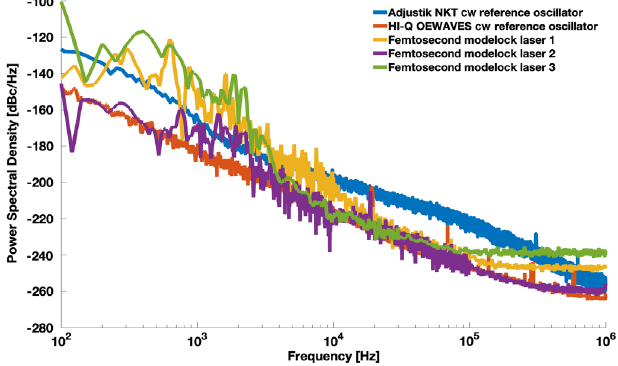
FIG. 3. Top: power spectral density of phase noise measured from self heterodyne beating for two cw reference oscillators and heterodyne beating with the HighQ OEwaves cw reference oscillator for three commercial femtosecond mode-lock oscilla- tors. The phase noise PSD is shown for a carrier frequency of 40 MHz that corresponds to the repetition frequency required for the Gamma Factory POP